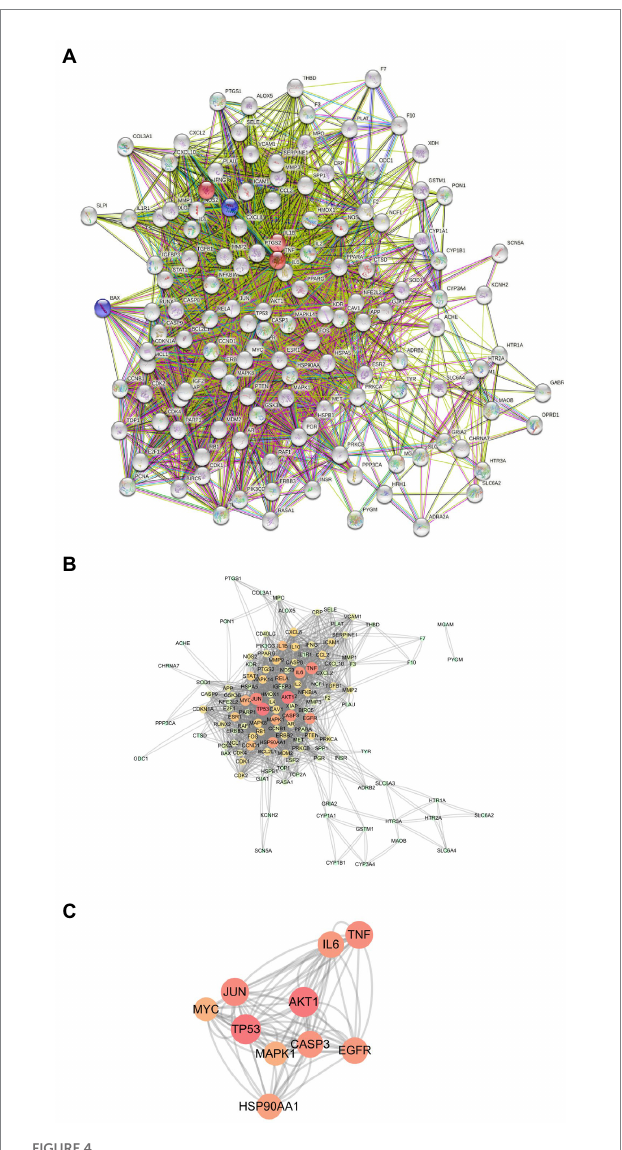
FIGURE 4 PPI Network Analysis. (A) PPI network of 133 potential targets of EPI for SCI. (B) PPI network constructed with Cytoscape software (The darker the node color, the higher the number of connected proteins). (C) The key targets of EPI for SCI